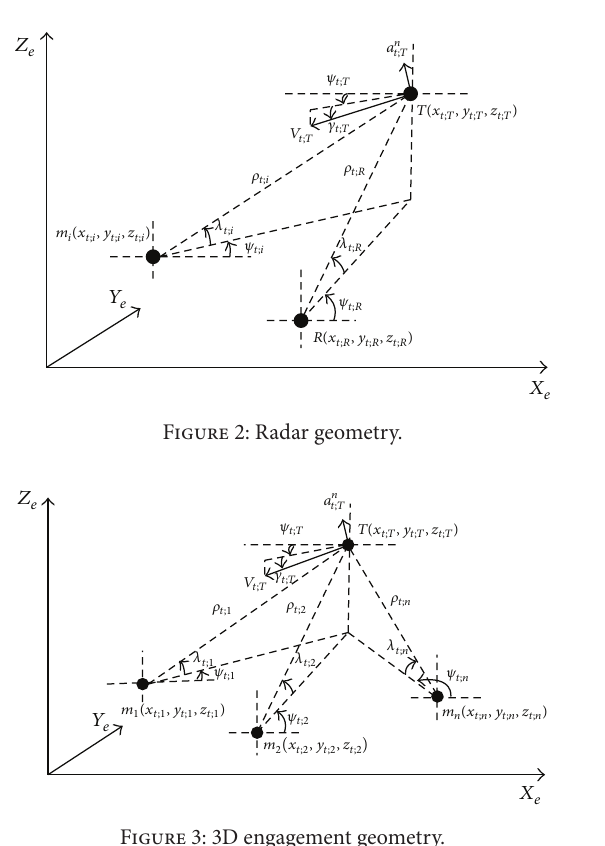
Figure 3: 3D engagement